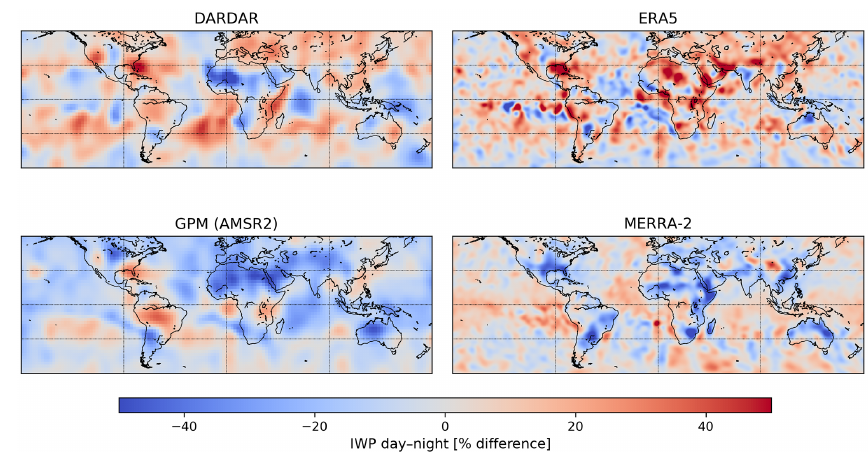
Figure 8. Daytime minus night-time differences in IWP at A-Train crossing times, shown as percent differences. Fields have been smoothed to aid comparison. Due to availability, data from 2015 are used for all except DARDAR, for which the data are from 2008 to